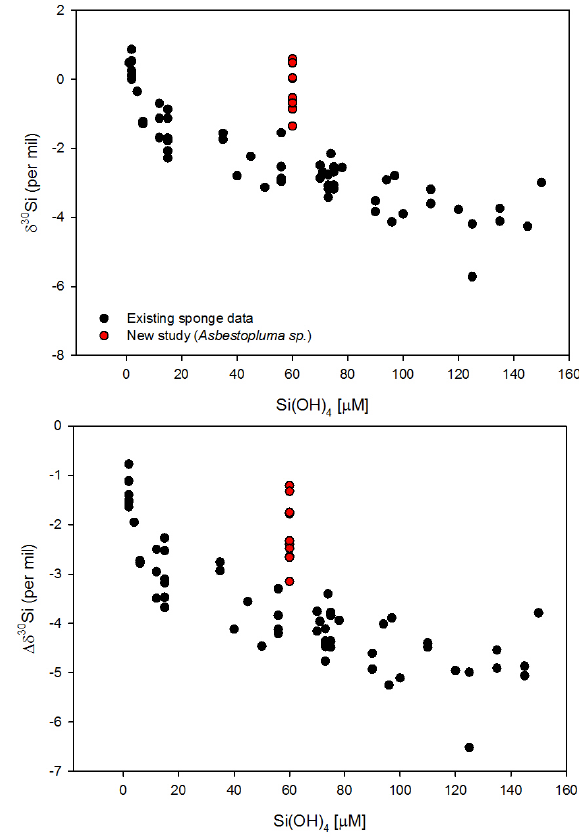
Figure 5. Comparison of δ 30 Si and (cid:49)δ 30 Si ( = δ 30 Si sponge − δ 30 Si seawater ) results from DH19-2 Asbestopluma sp. (red symbols) and existing calibration (black symbols). Data for sponge δ 30 Si and references for seawater δ 30 Si from Hendry et al. (2010), Hendry and Robinson (2012), and Wille et al.